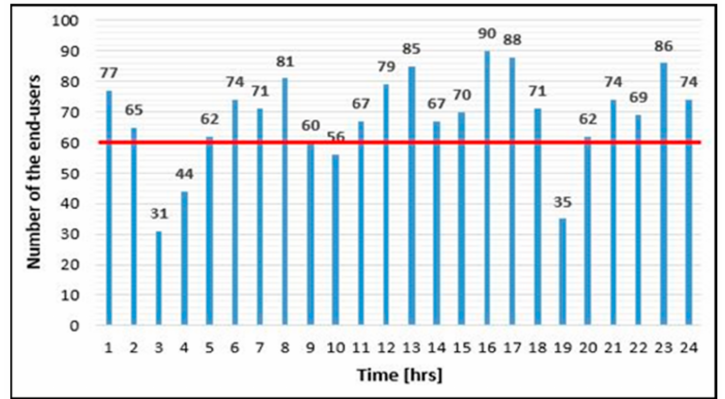
Figure 14. The number of end-users who participated in the PLB